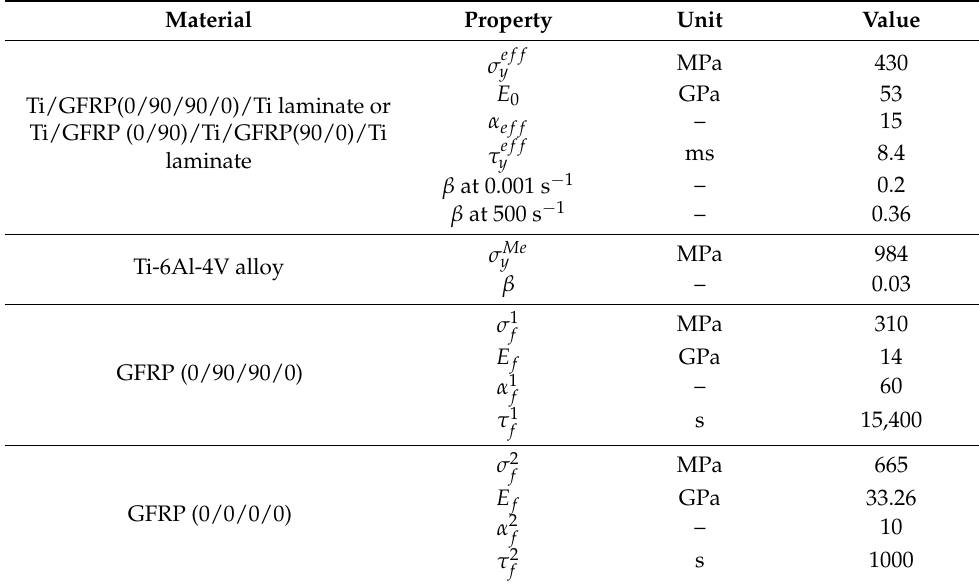
Table 3. Parameters of the model and materials [17,18] for the calculated deformation curves of the GLARE Ti/GFRP(0/90/90/0)/Ti composite laminate and Ti/GFRP(0/90)/Ti/GFRP(90/0)/Ti laminate in Figures 2b and